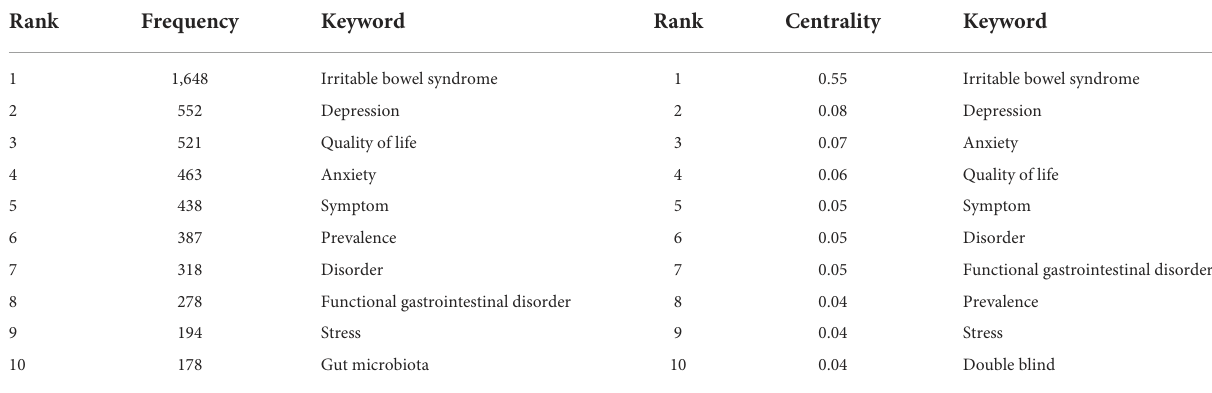
TABLE 6 Top 10 keywords in terms of frequency and centrality in the